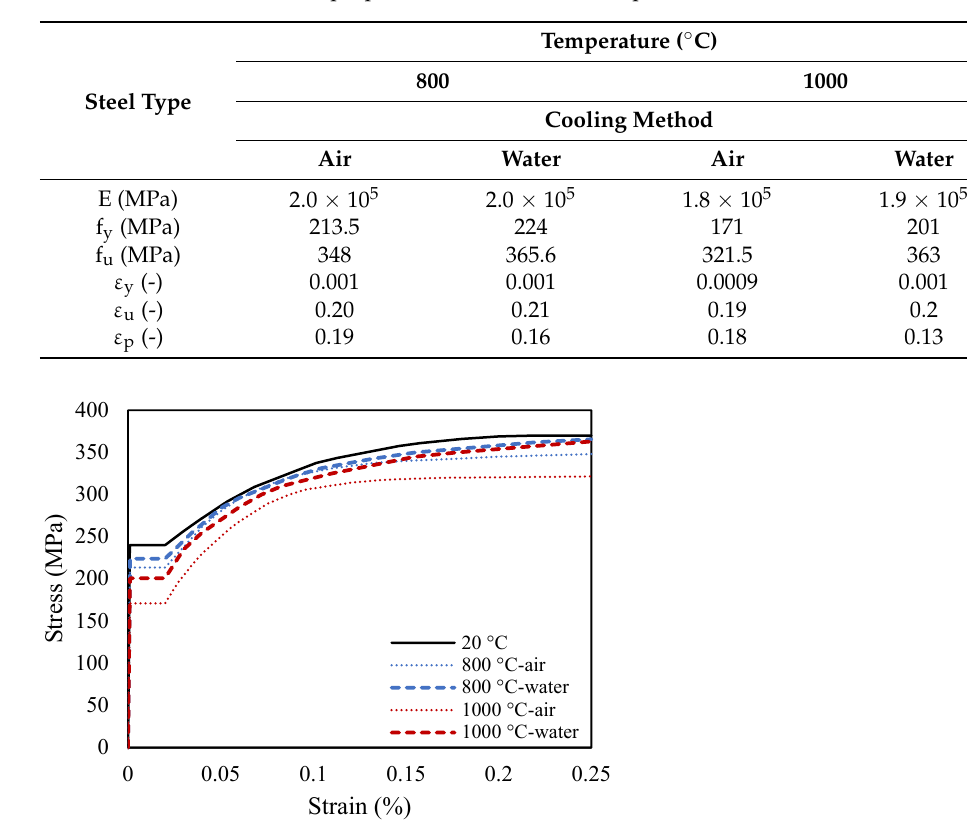
Table 1. Post-fire mechanical properties at two elevated temperatures.